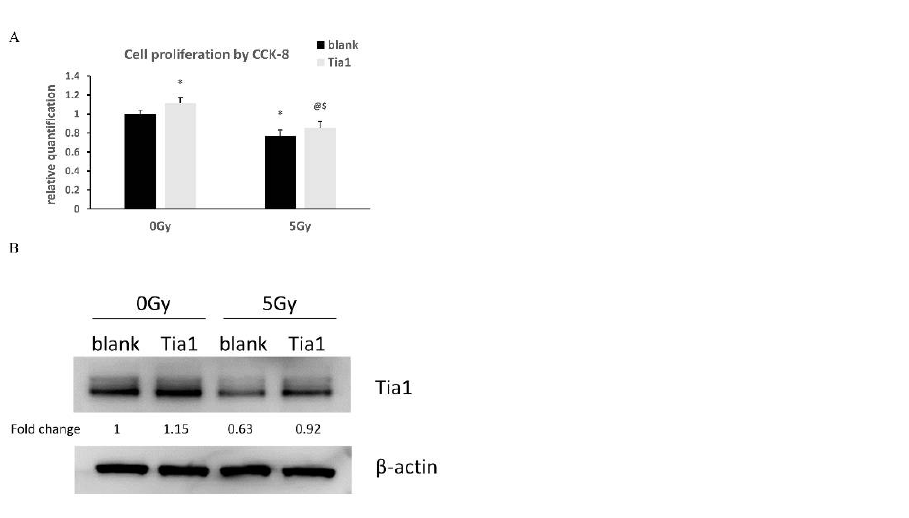
Figure 9. Effects of overexpression of Tia1 in NSCs after γ -irradiation. pCMV6-AC-GFP containing Tia1 or blank control was transfected into NSCs, which were then γ -irradiated with 5Gy or not irradiated as a control. ( A ) Cell proliferation in transfected NSCs. Data are expressed as mean ± SEM ( n = 5). * p < 0.05 vs blank 0 Gy; @ p < 0.05 vs. Tia1 0 Gy; $ p < 0.05 vs. blank 5 Gy. ( B ) Protein expression of Tia1 in transfected NSCs examined by western